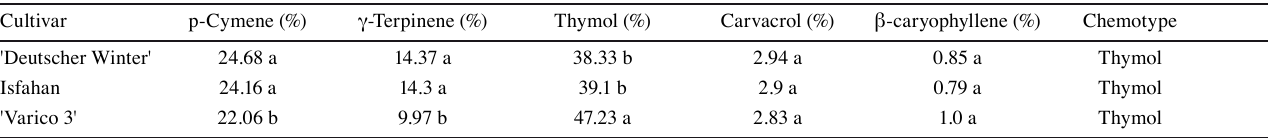
Tab. 6: Major constituents in essential oil of T. vulgaris